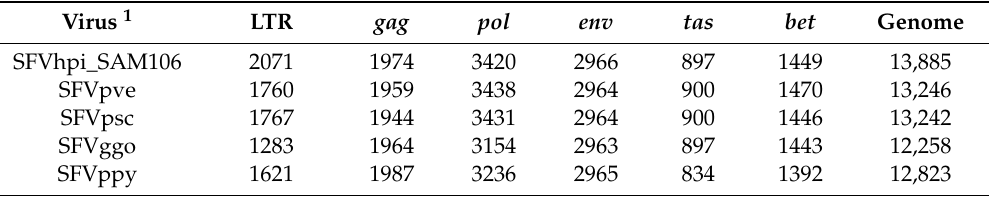
Table 2. Ape simian foamy virus (SFV) gene and genome nucleotide length comparison. Virus